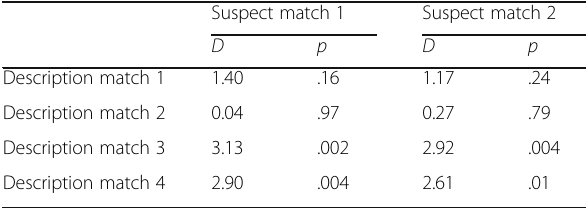
Table 5 Results of receiver operating characteristic analysis for Experiment 2 Table 6 Comparison of each suspect-matched lineup with each pAUC description-matched lineup from Experiment